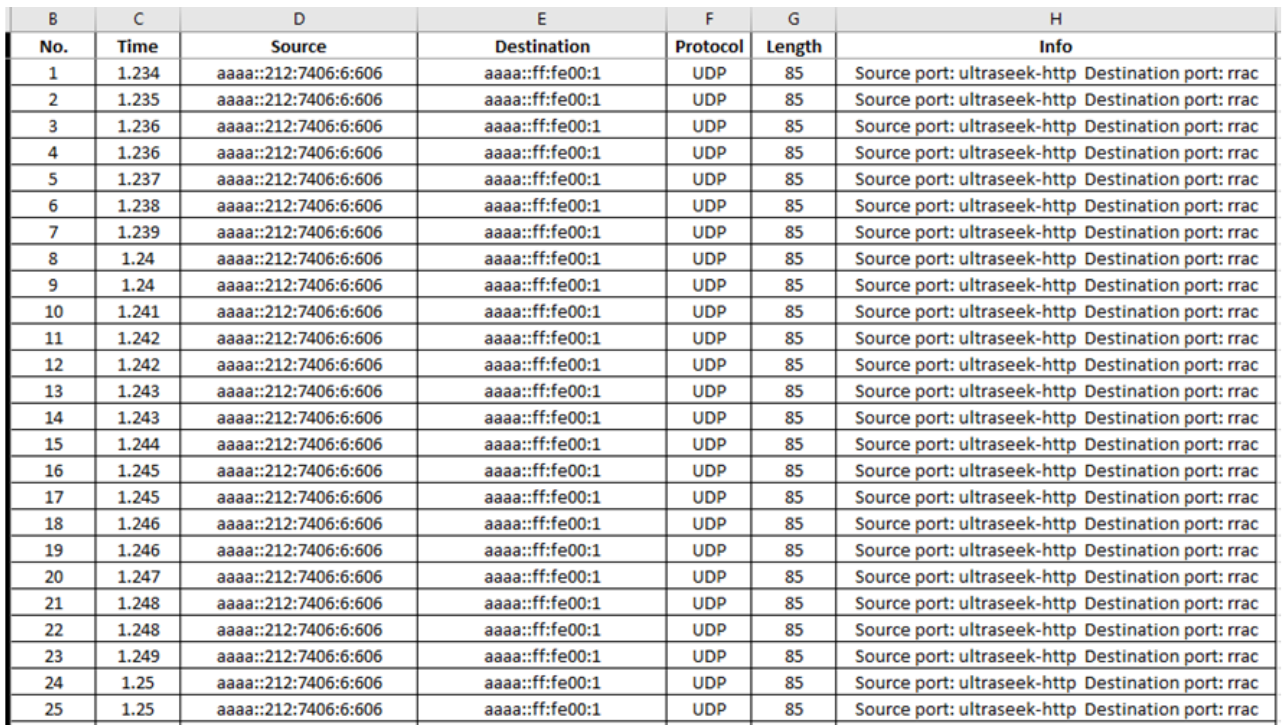
Figure 36. Malicious “radiologUDP.csv”— 1 to 25 records .